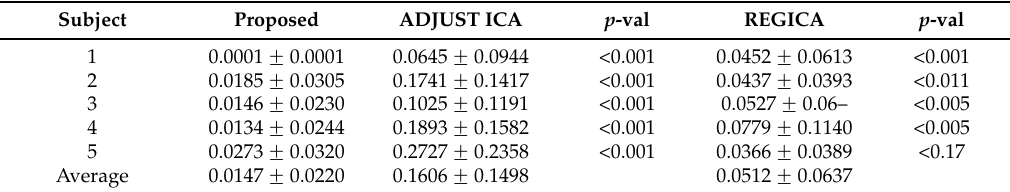
Figure 9. Comparison of the proposed algorithm with ADJUST and REGICA in frequency domain at Fp1 and Oz. ( A ) EEG spectra after applying filter 0.5–40 Hz; ( B ) EEG spectra after applying filter 0.5–20 Hz. Table 2. Relative error values results for the proposed algorithm against ADJUST and REGICA using artifact-free EEG data.